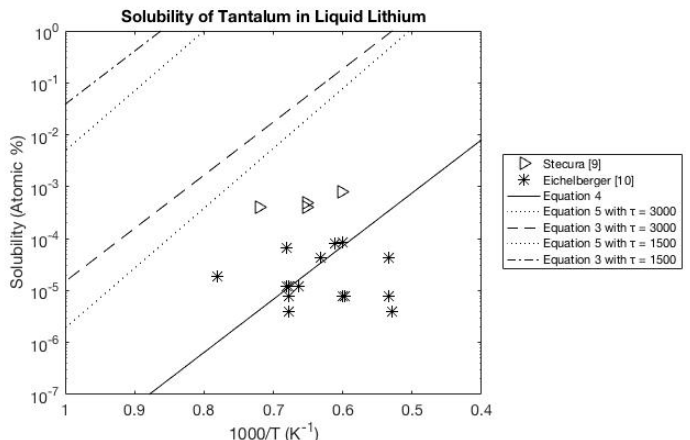
Figure 1. Solubility of tantalum in liquid lithium.